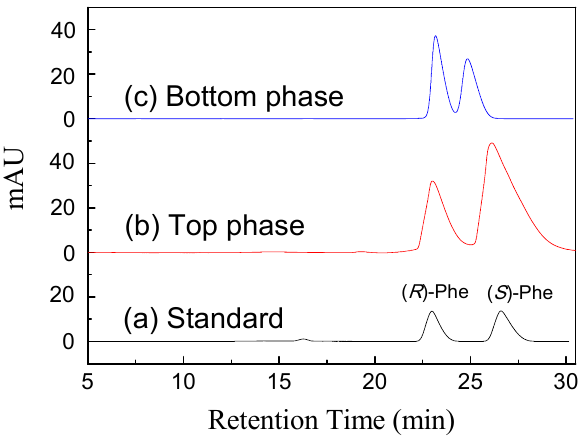
Figure 9. The HPLC chromatograms for phenylalanine enantiomers in ATPS. ( a ) phenylalanine standard, ( b ) phenylalanine sample withdrawn in the top phase, and ( c ) phenylalanine sample withdrawn in the bottom phase.